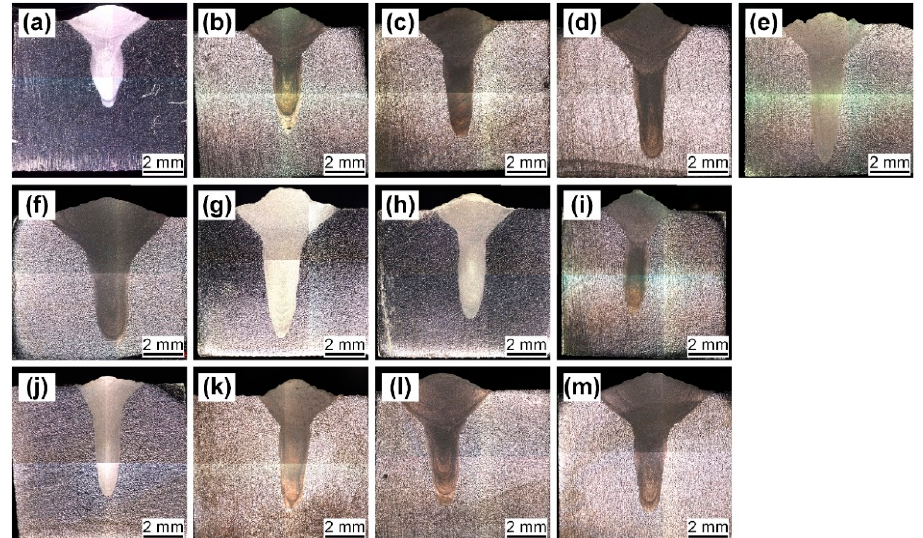
Figure 6. Weld cross-sectional morphologies; ( a – e ) laser power at 3, 3.5, 4, 4.5 and 5 kW under given welding speed of 1.8 m/min and welding current of 100 A, ( f – i ) welding speed at 1.2, 1.5, 2.1 and 2.4 m/min under given laser power of 4 kW and welding current of 100 A and ( j – m ) welding current at 50, 75, 125 and 150 A under given laser power of 4 kW and welding speed of 1.8 m/min.